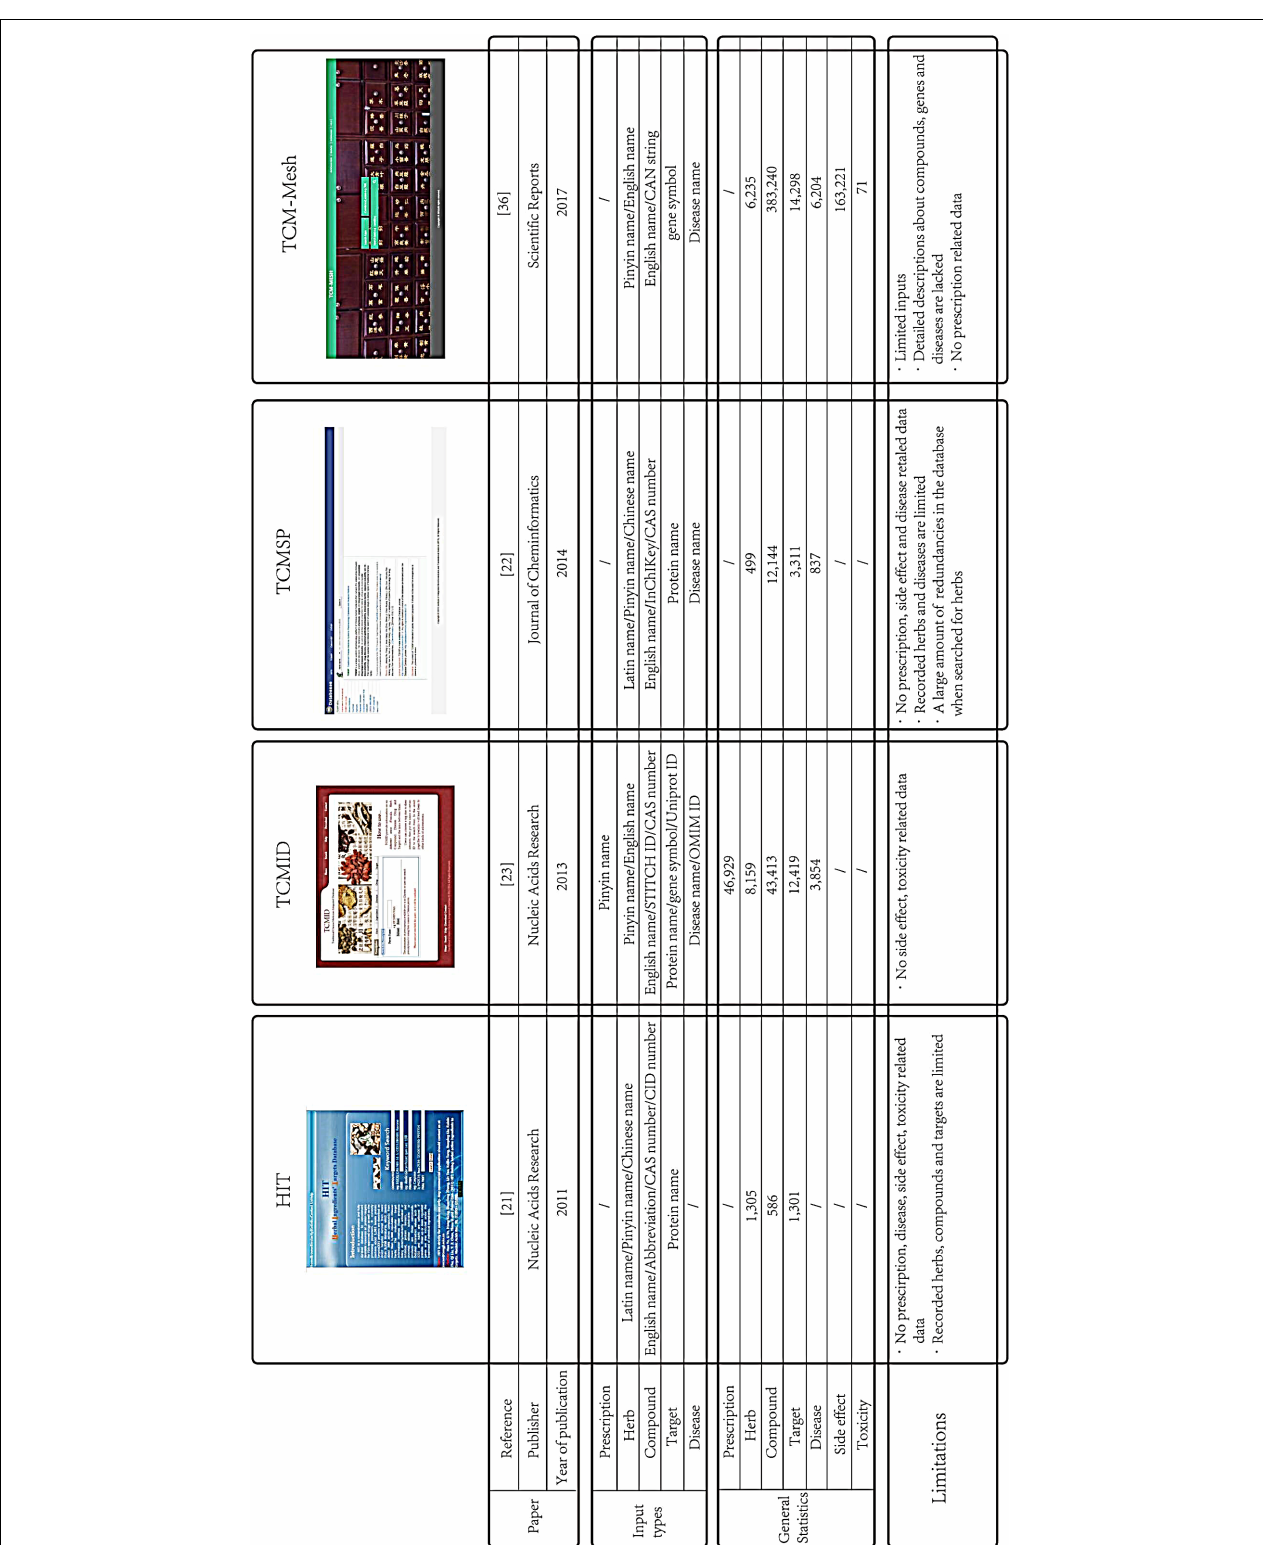
FIGURE 3 | Comparisons among the four TCM databases. The comparison contains the paper information, different input types, general statistics, and limitations of several TCM databases.